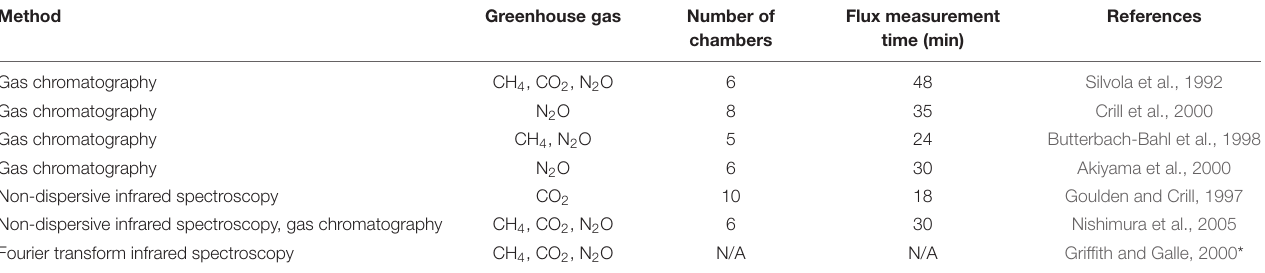
TABLE 1 | Pioneer methods for automated greenhouse gas flux